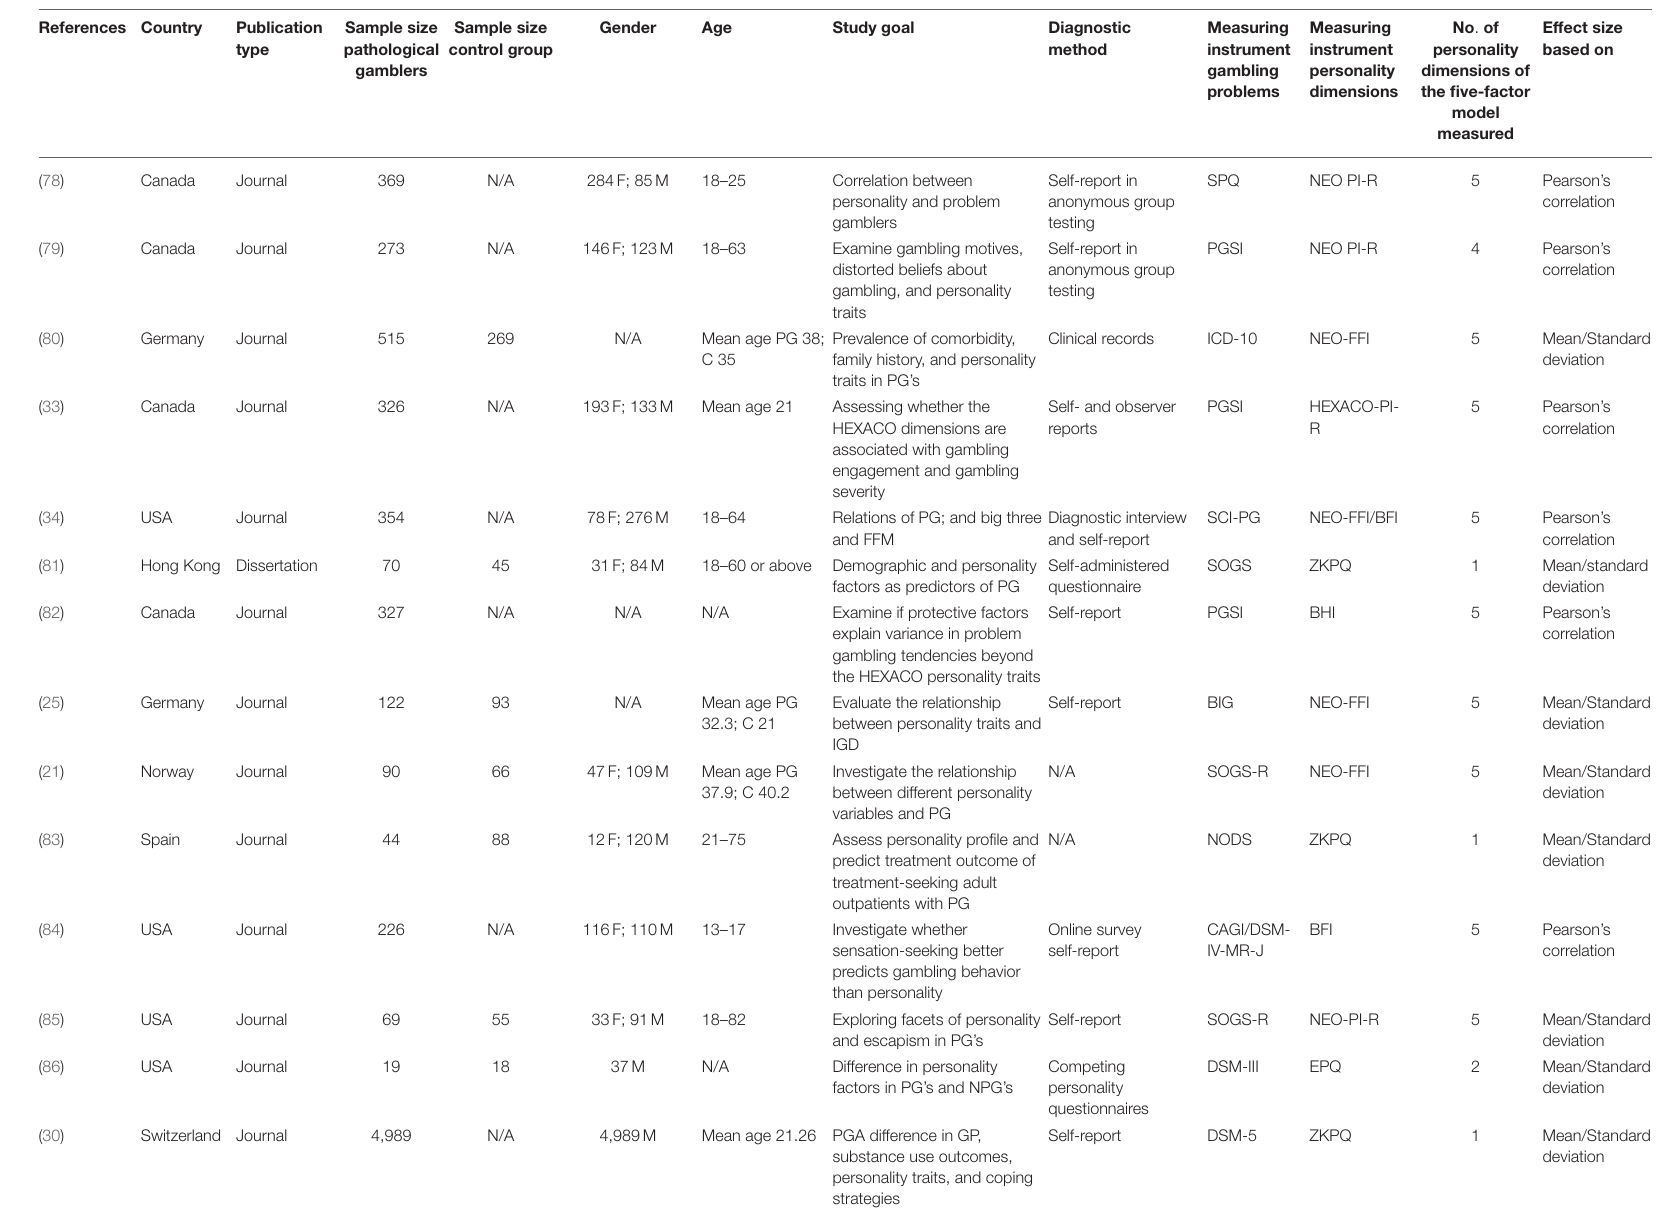
Difference in personality factors in PG’s and NPG’s Mean age 21.26 PGA difference in GP, substance use outcomes, personality traits, and coping strategies